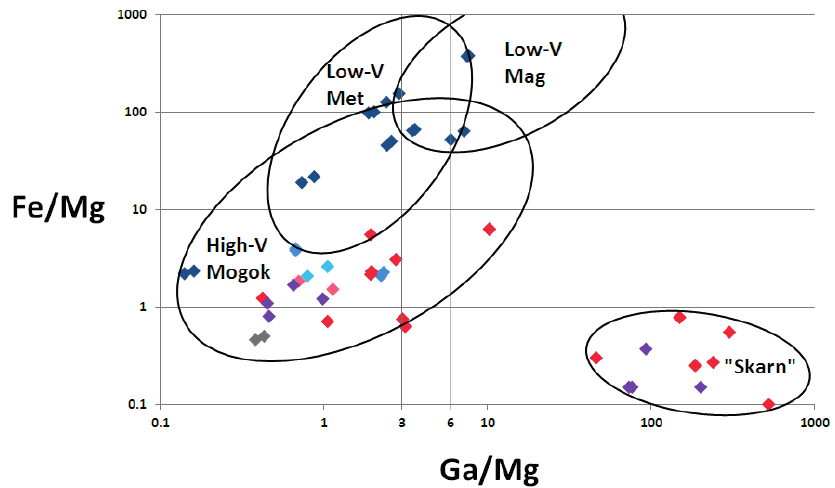
Figure 6. Fe/Mg–Ga/Mg plots, Mogok